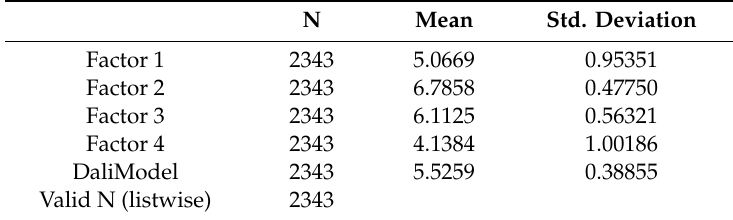
Table 3. Dali model.